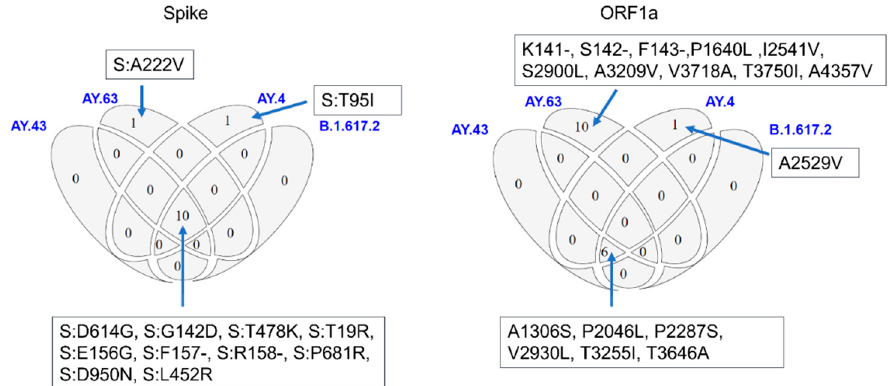
Figure 5. Genetic characteristics of AY.63. Overview of spike and ORF1a mutations shared between the most common Delta variants in week 23–48.